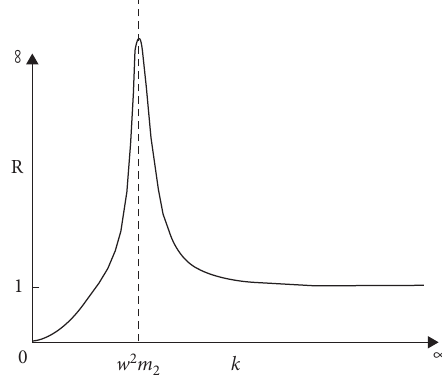
Figure 3: Relationship between stiffness and amplitude ratio of bonding section of dangerous rock